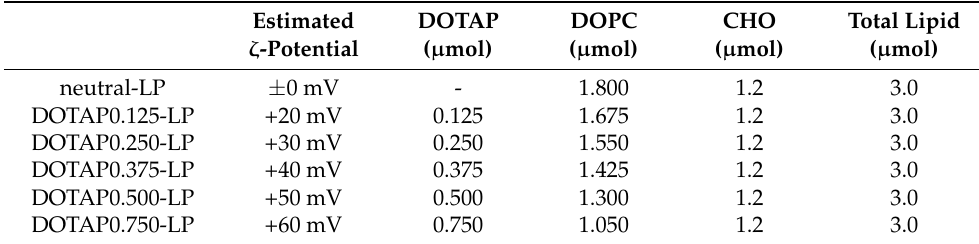
Table 1. Composition ratios of